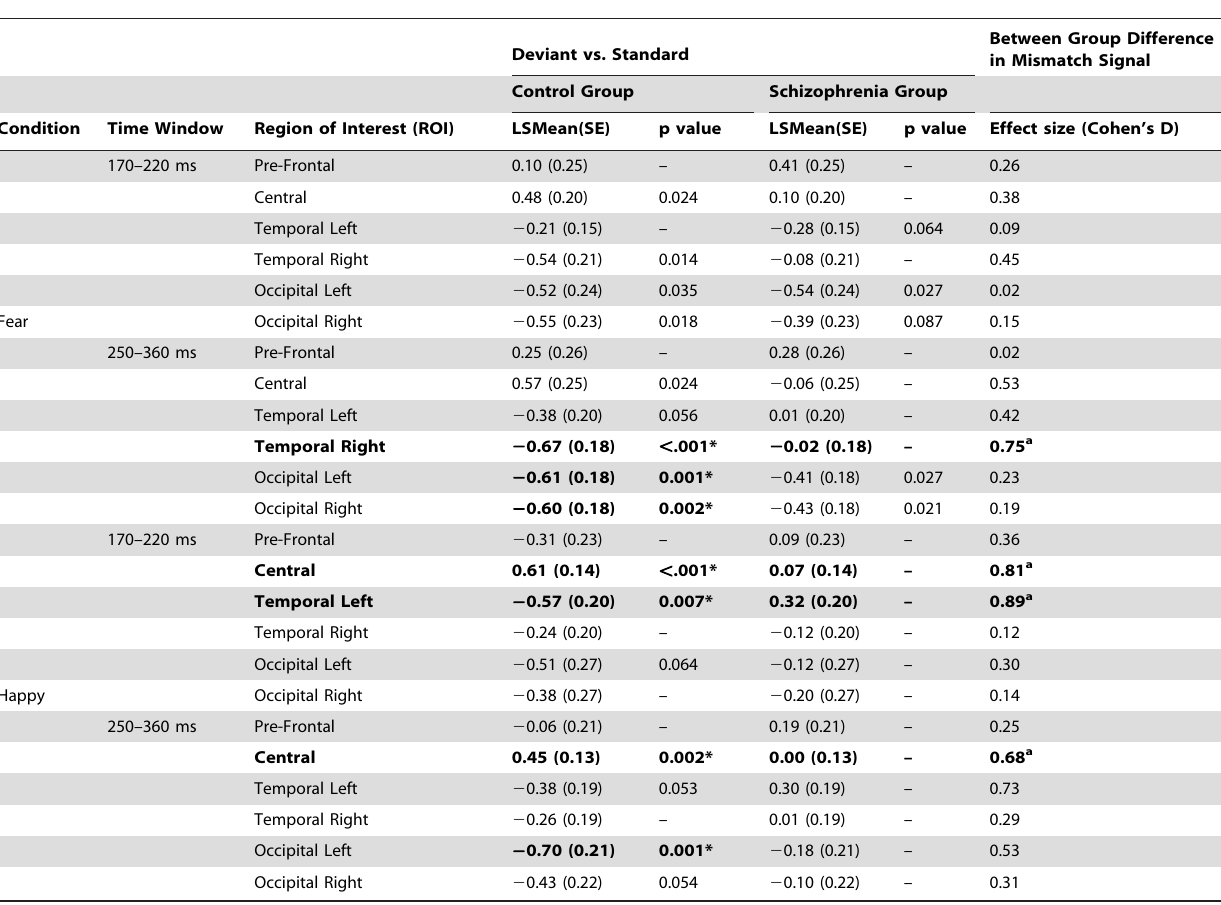
Table 3. Between group differences in mismatch responses by region and emotion